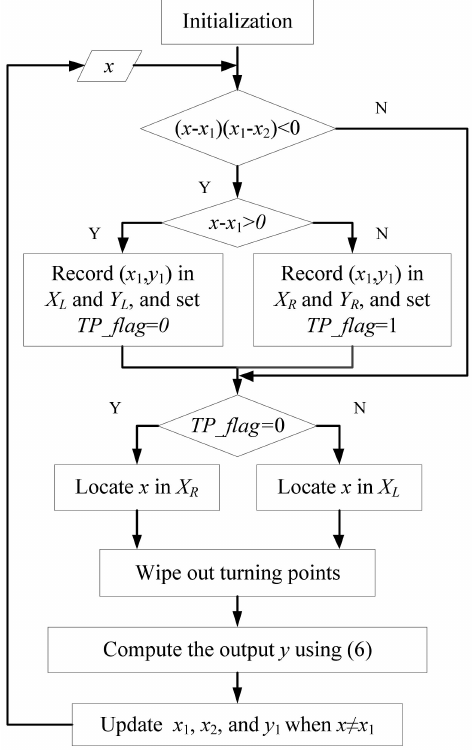
Figure 6. Realization algorithm of the proposed hysteresis